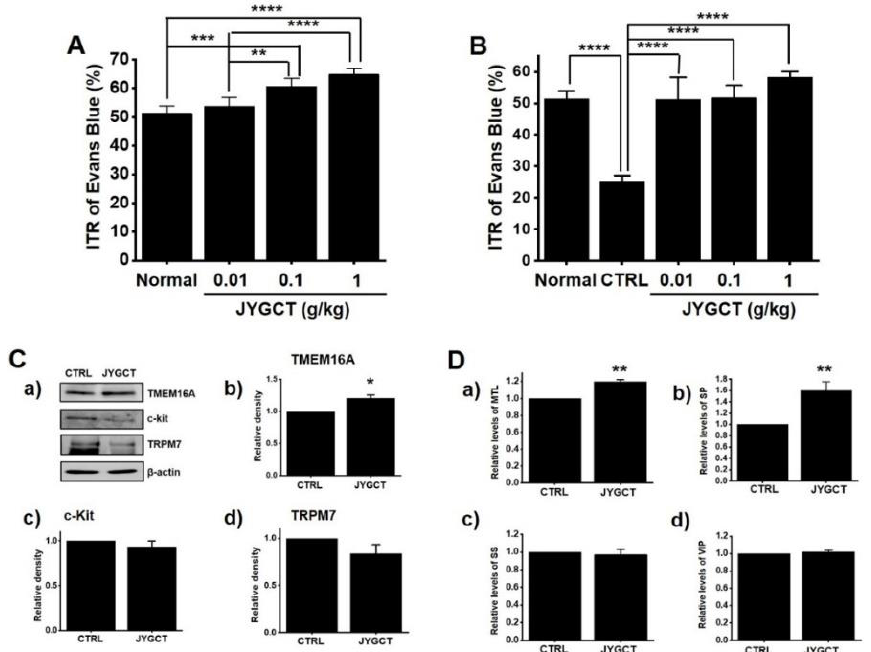
Figure 5. Effects of JYGCT on protein expressions and gut hormones in ITR. ( A , B ) JYGCT increased ITR; ( C ) The expression of TMEM16A increased but that of c-Kit or TRPM7 was unchanged; ( D ) Level changes of GI hormones, (a) MTL, (b) SP, (c) SS, and (d) VIP. Bars represents the mean ± SE. * p < 0.05. ** p < 0.01. *** p < 0.001. **** p < 0.0001. JYGCT: Jakyakgamcho-tang; CTRL: control.